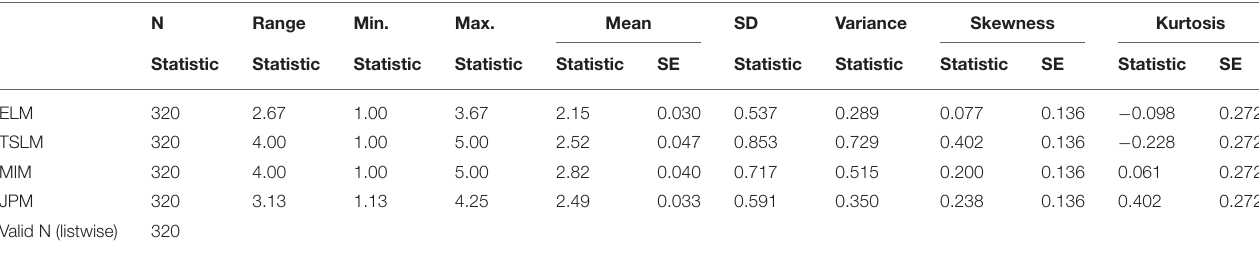
TABLE 1 | Reliability